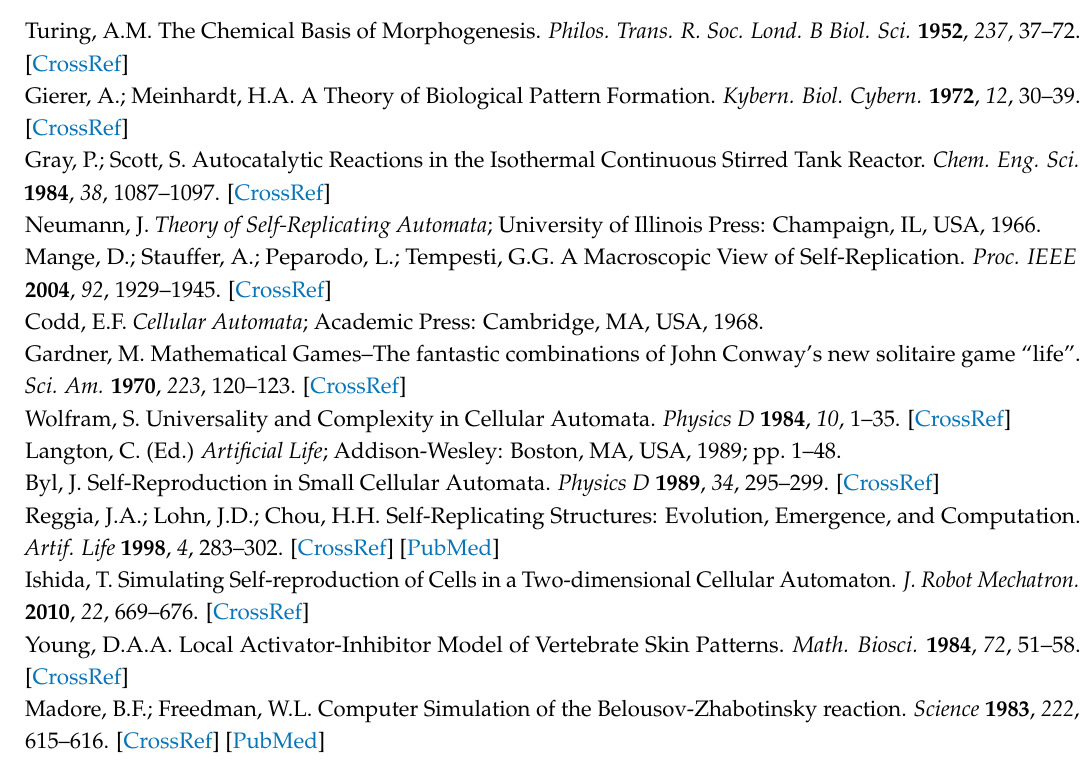
Video S1: Video of Figure 12 (Results for the model with s = 4, t = 8, w 1 = 0.40, and w 2 = 0.75 in a hexagonal grid); Video S2: Video of Figure 20 (Calculation results in which w 1 and w 2 are changed over time at each